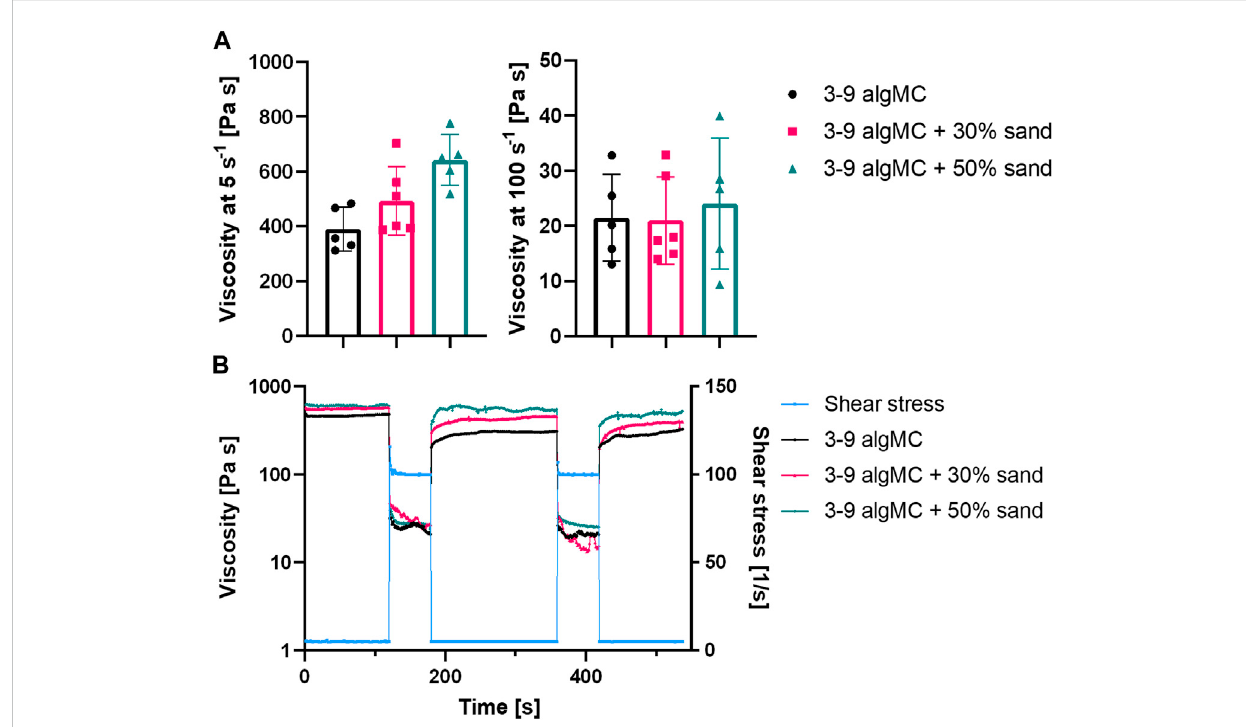
FIGURE 2 Rheologicalcharacterizationofthe3 wt%alginateand9 wt%methylcellulose(algMC)inkwiththeadditionof30 wt%and50 wt%sand. (A) Viscosity of inks at low (5 s -1 ) and high (100 s -1 ) shear rates (mean ± SD, n ≥ 5); (B) Representative measurements of the shear recovery